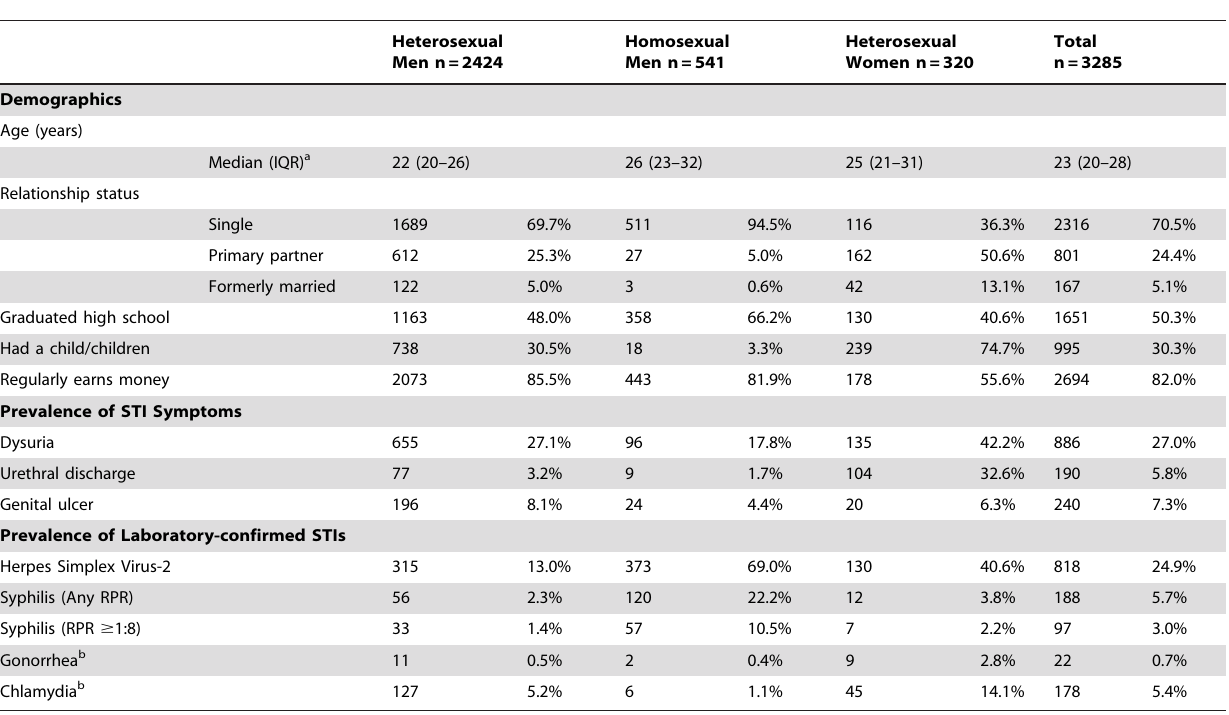
Table 1. Socio-demographic Factors, Reported Genitourinary Symptoms, and Prevalence of Laboratory-confirmed STIs; Lima, Trujillo, and Chiclayo, Peru; 2003–05.